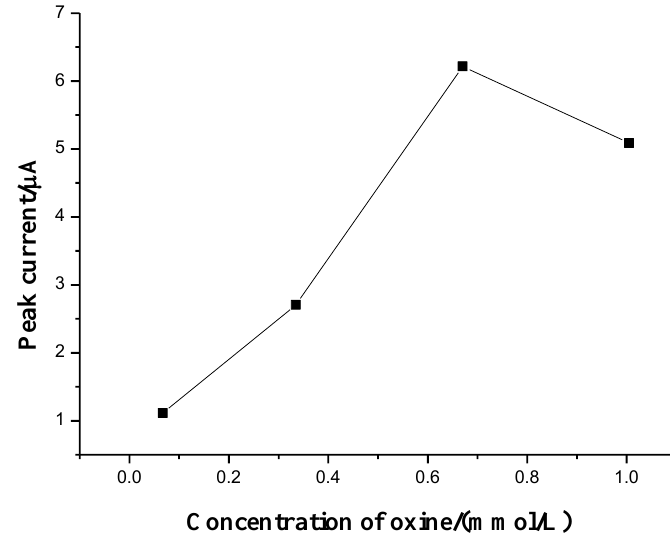
Figure 4. Effect of oxine concentration on the extraction efficiency of LPME. LPME conditions are as in Figure 3 except the concentration of oxine. Deposition potential: − 1.8 V (vs. Ag/AgCl); deposition time: 120 s; quiet time: 10.0 s; frequency: 20.0 Hz; pulse amplitude: 25.0 mV; scan increment: 4.0 mV. All measurements were made in triplicate and the results were averaged.